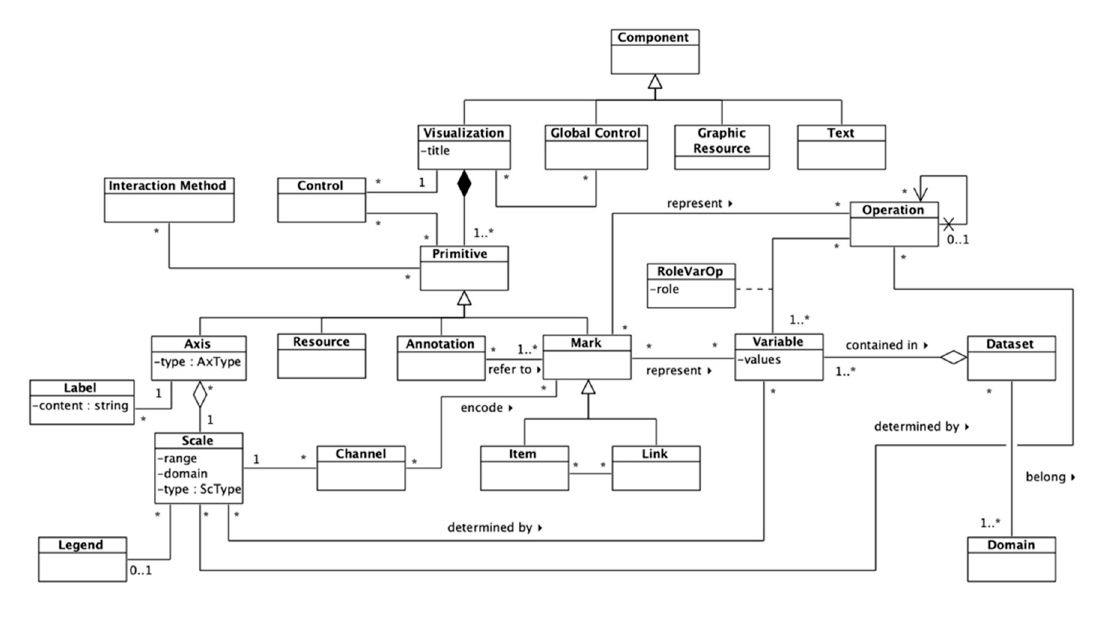
Figure 2. Components section of the dashboard meta-model